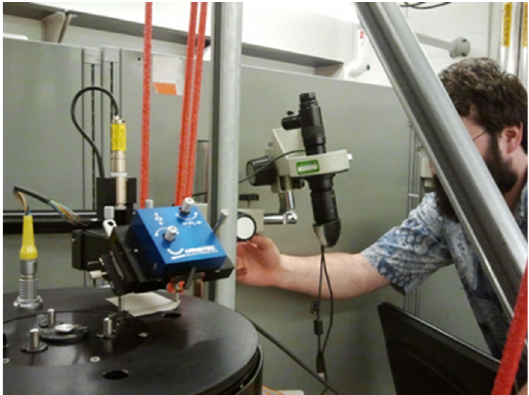
FIG. 4. Ex situ AFM. The system is mechanically isolated from the ground by stiff springs in order to minimize vibration-induced noise in the topographic images.